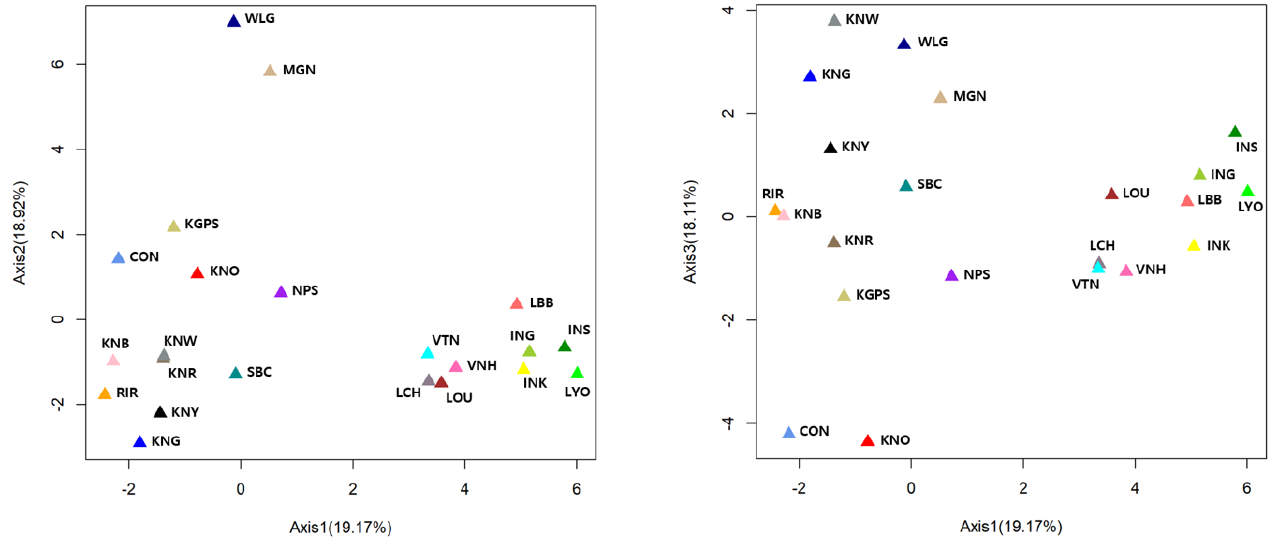
Figure 3. Principal coordinate analysis (PCoA) of allele frequencies from 20 microsatellite markers in 22 chicken breeds. The percentage of the variation explained by the plotted principal coordinates is indicated on the axes. RIR, Rhode Island Red; WLG, White Leghorn; CON, Cornish; KNG, Korean Grayish-brown; KNB, Korean Black; KNR, Korean Reddish-brown; KNW, Korean White; KNY, Korean Yellowish-brown; KNO, Korean Ogye; MGN, Mrtmiongolian Nuthiin bor; INK, Indonesian KUB; INS, Indonesian Sensi; ING, Indonesian Gaok; KGPS, Kyrzyzstani GPS-H; LYO, Laotian York; LCH, Lotian Chae; LBB, Laotian Black Bone; LOU, Latotian Ou; NPS, Nepalese Sakini; SBC, Sri Lankan Junglefowl; VTN, Vietnamese Ninh Hoa; VNH, Vietnamese Ninh